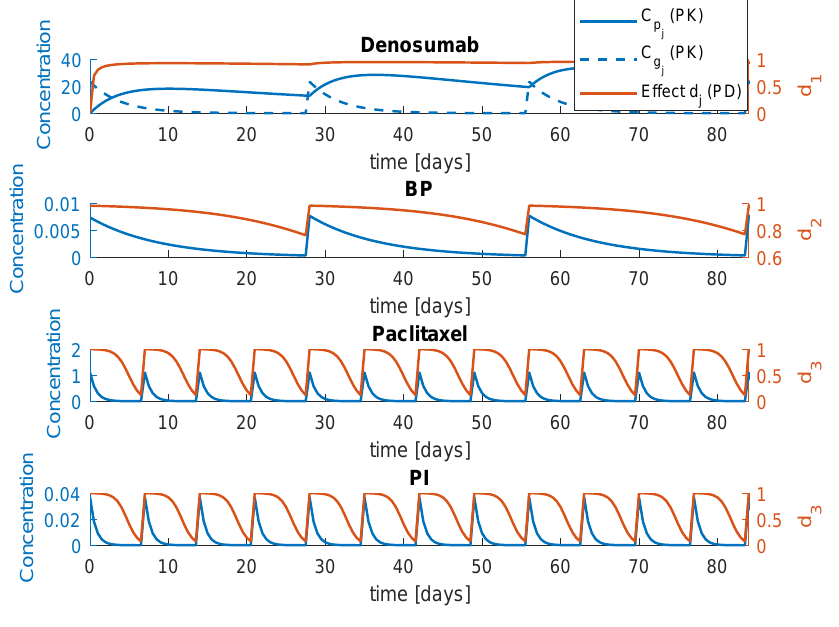
Figure 2. Pharmacokinetic/pharmacodynamic (PK/PD) behaviour of T 1 , T 2 , T 3 and T 4 ; concentrations in